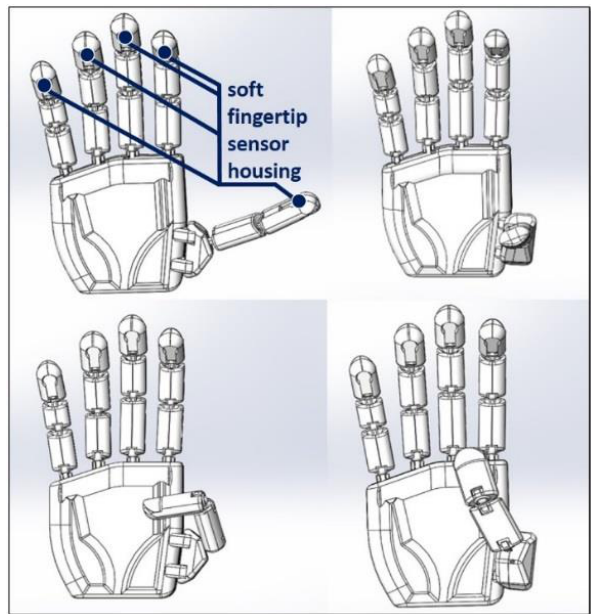
Figure 1. The anthropomorphic robotic and prosthetic hand.